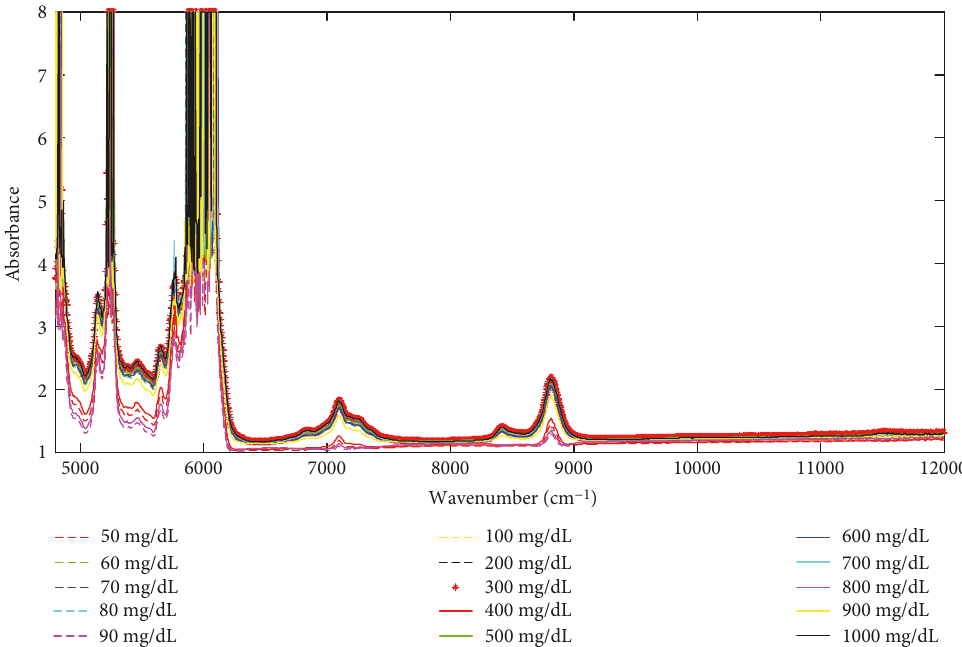
Figure 4: Near-infrared spectral data of glucose